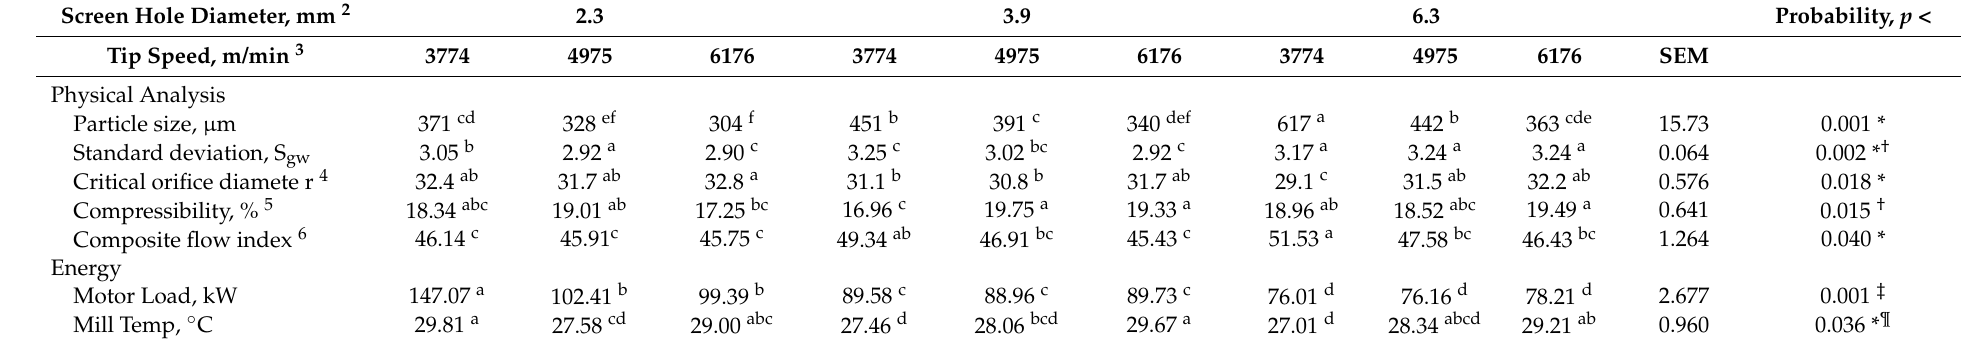
Table 2. Influence of 2-way interaction of screen hole diameter × hammer tip speed on the energy consumption, particle size, and flowability of hammermilled corn 1 . Screen Hole Diameter, mm 2